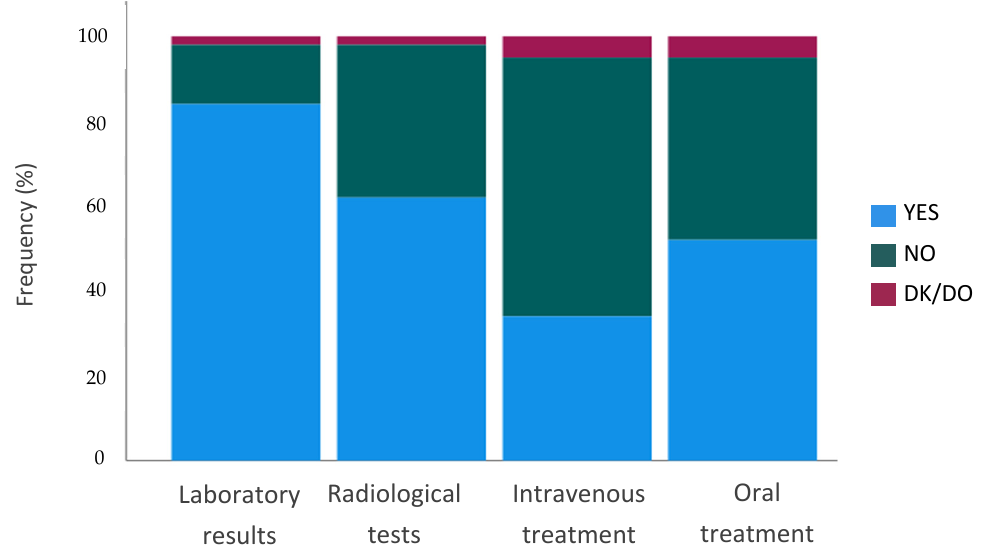
Figure 5. Preferences for the type of information given during a telemedicine visit. All patients. Q6–Q9. Would you agree to be informed via telemedicine of…?